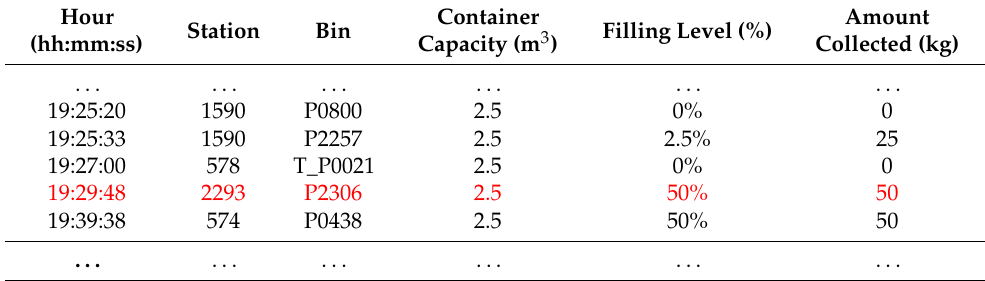
Table 6. Part of the visit sequence of a